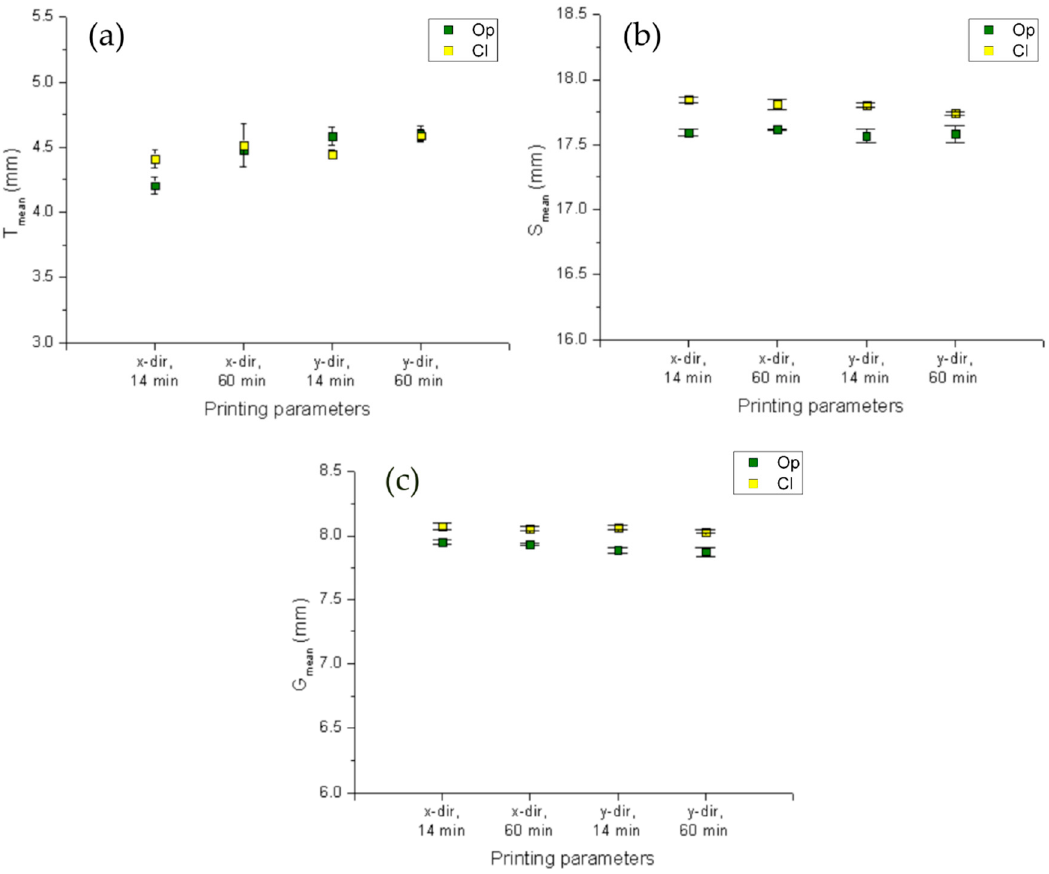
Figure 4. Plot of mean values of ( a ) T, ( b ) S, and ( c ) G both for Op and Cl resin. On the y axis, the same 2.5 units value span is reported to allow comparisons.